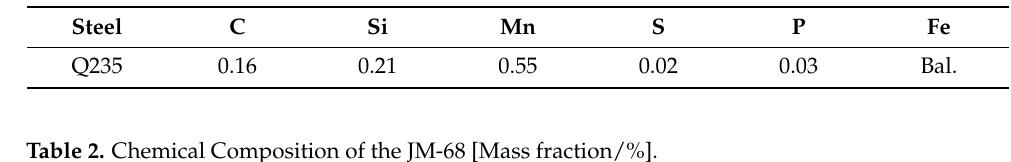
Table 2. Chemical Composition of the JM-68 [Mass fraction/%].